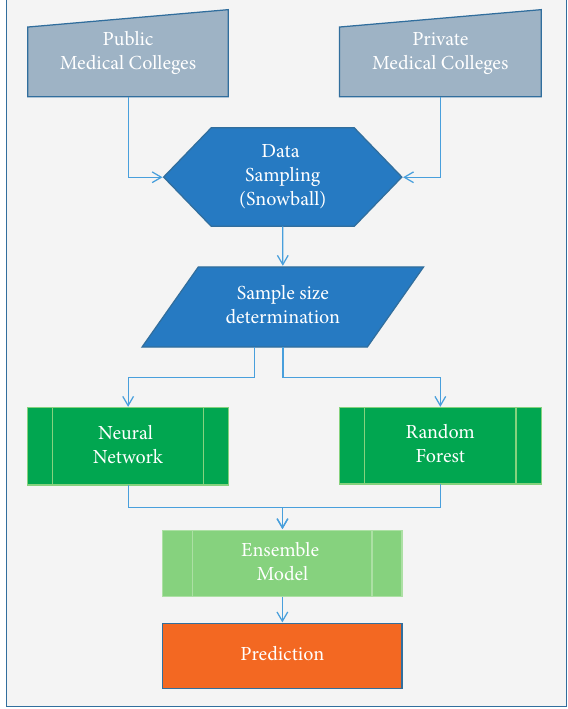
Figure 1: Employed methodology of young imposter syndrome prediction